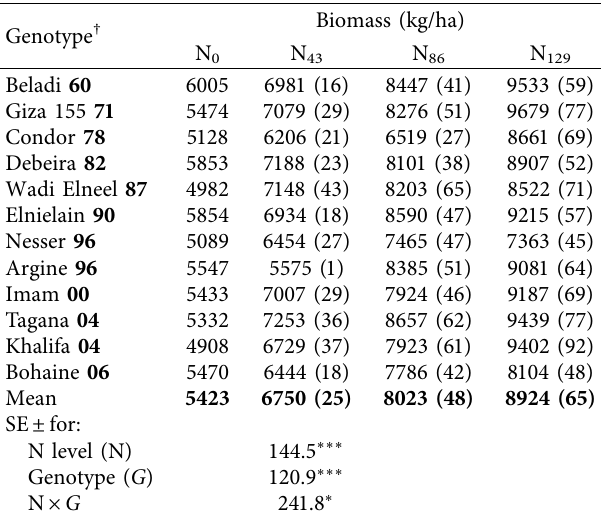
Table 2: Mean grain yield (kg/ha) of 12 bread wheat genotypes grown for two seasons under four N levels at Gezira Research Station Farm, Wad Medani,